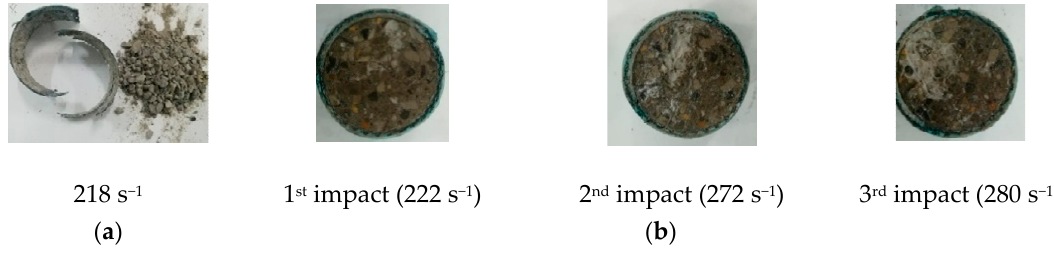
Figure 7. Failure modes of the concrete confined with the CFRP ( a ) and the PET FRP ( b ).